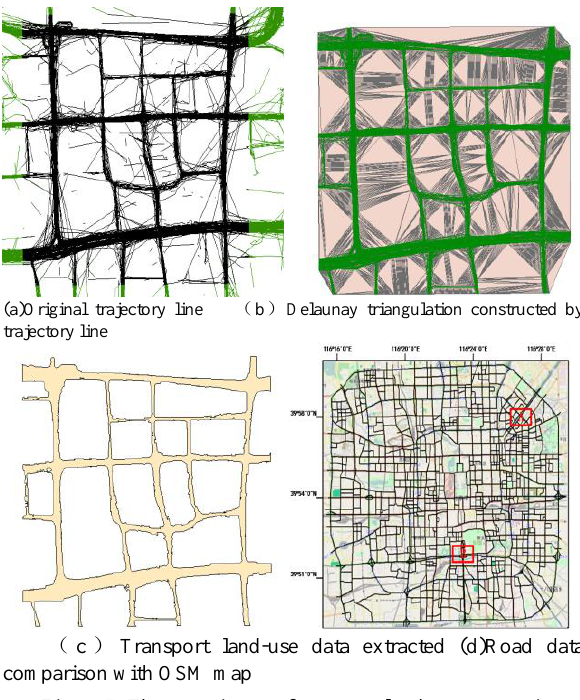
Figure 5. The experiment of transport land-use generation using vehicle movement